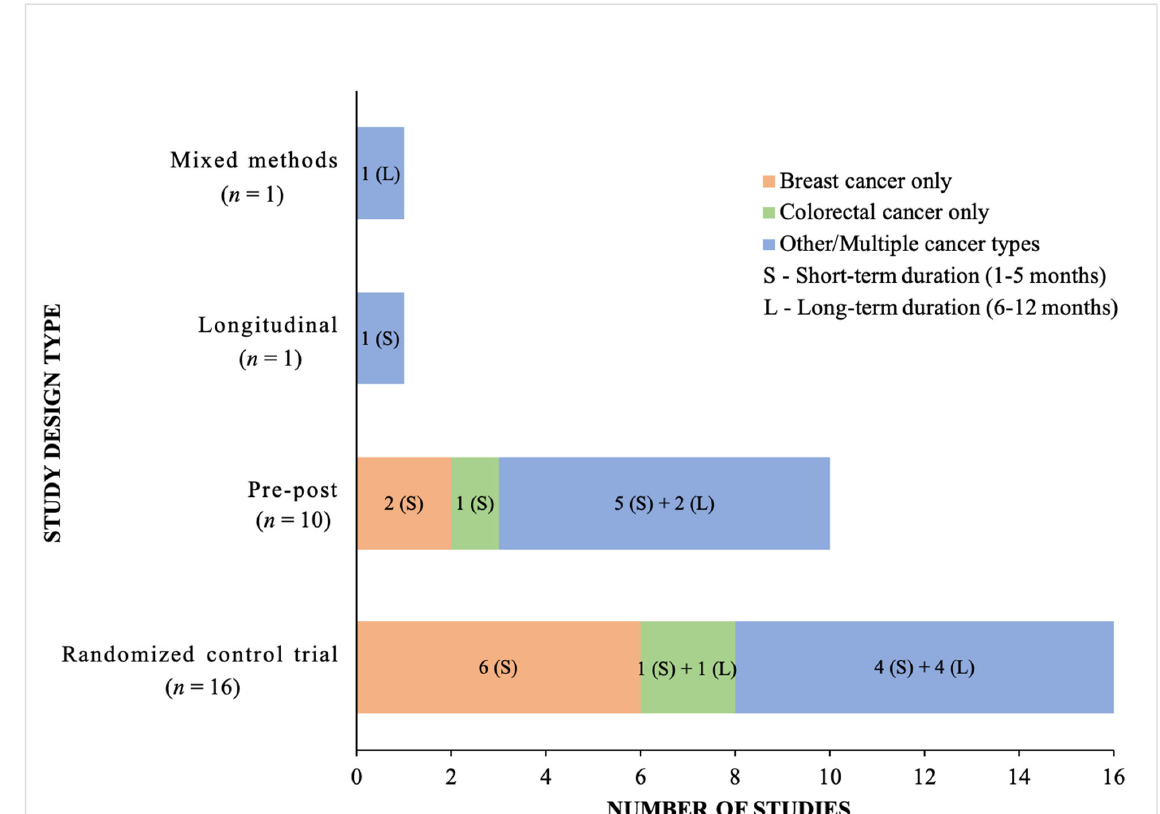
Figure 2. Study designs tabulated by cancer type and duration of intervention.